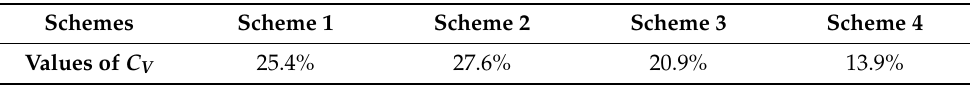
Table 3. Summary of C V values of the velocity field distribution for the upstream cross-section of the catalyst inlet corresponding to different